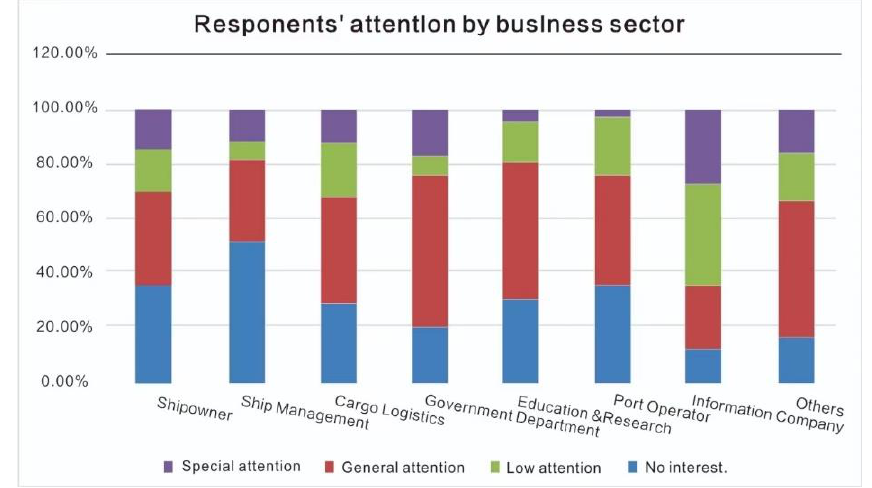
Figure 2. Respondents ’ attention by the business sector.